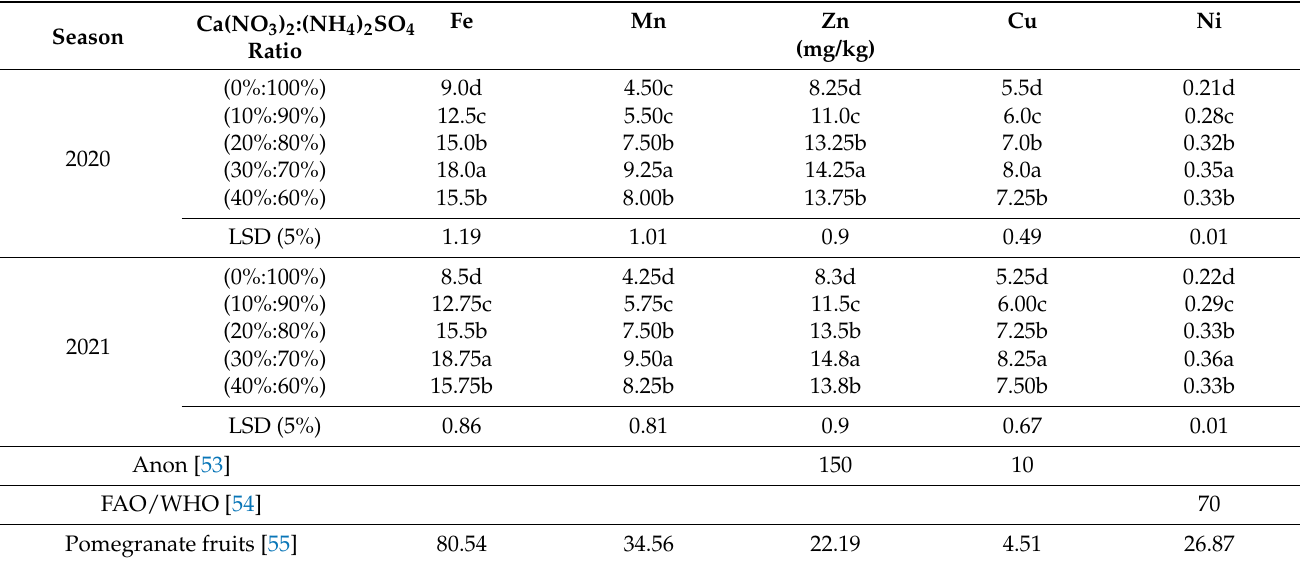
Table 7. The impact of Ca(NO 3 ) 2 : (NH 4 ) 2 SO 4 ratios on Fe, Mn, Zn, Cu, and Ni, of the pomegranate fruits of cv. ‘Wonderful’ in 2020 and 2021